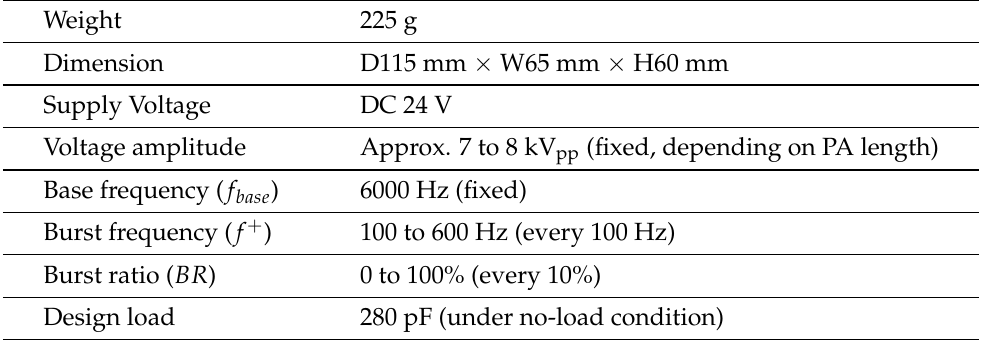
Figure 4. Small HV power supply used for flight test. Table 2. Specifications of small HV power